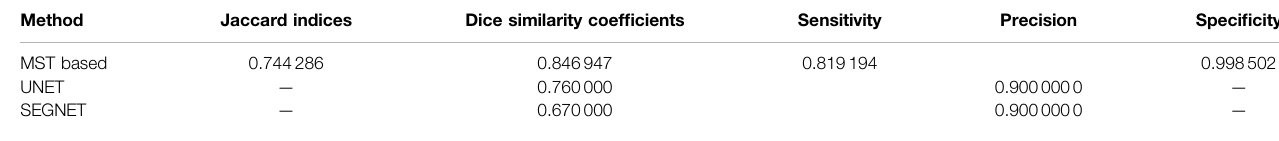
TABLE 2 | The performance of the minimum spanning tree approach compared to UNET and SEGNET based on data set number one, presented using average in each measure of similarity.